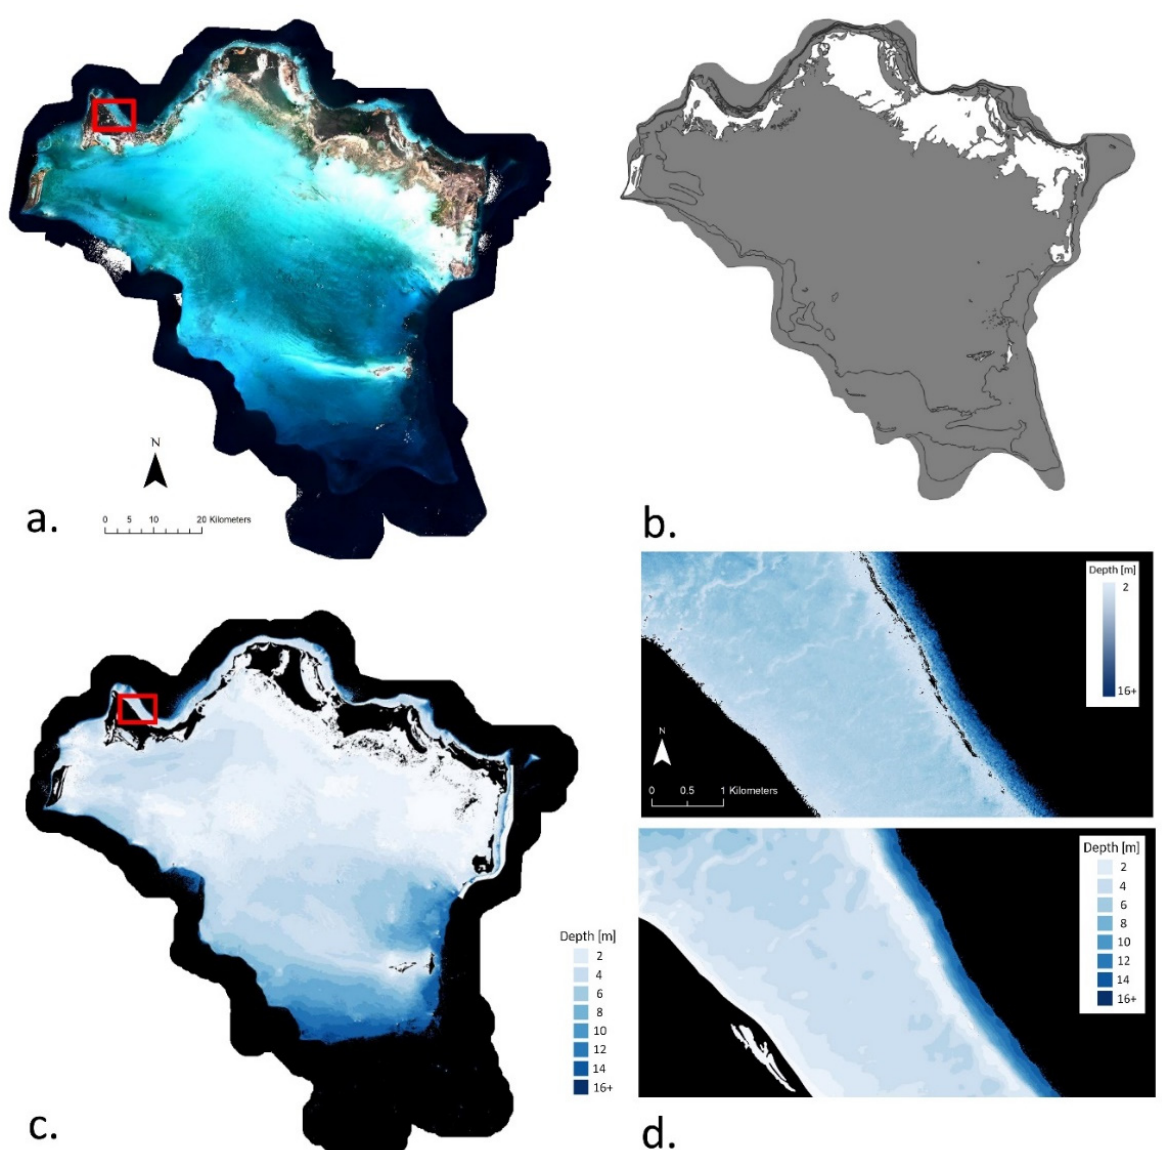
Figure 7. ( a ) True color surface reflectance image composite of Turks and Caicos Islands. Red rectangle shows the location of Grace Bay in Figure 3d; ( b ) masking of land, shallow (<30 m), and deep ocean (>30 m) areas using the geomorphic zone polygons; ( c ) Shallow bathymetry model (<20 m depth) based on PS surface reflectance; ( d ) Detailed view of the depth classification using 1-m increments for depths between 0–10 m and 2-m increments for areas >10 m depth, highlighting the shallow lagoons, reef crest, and steep slope beyond the fore reef leading to the deep ocean.